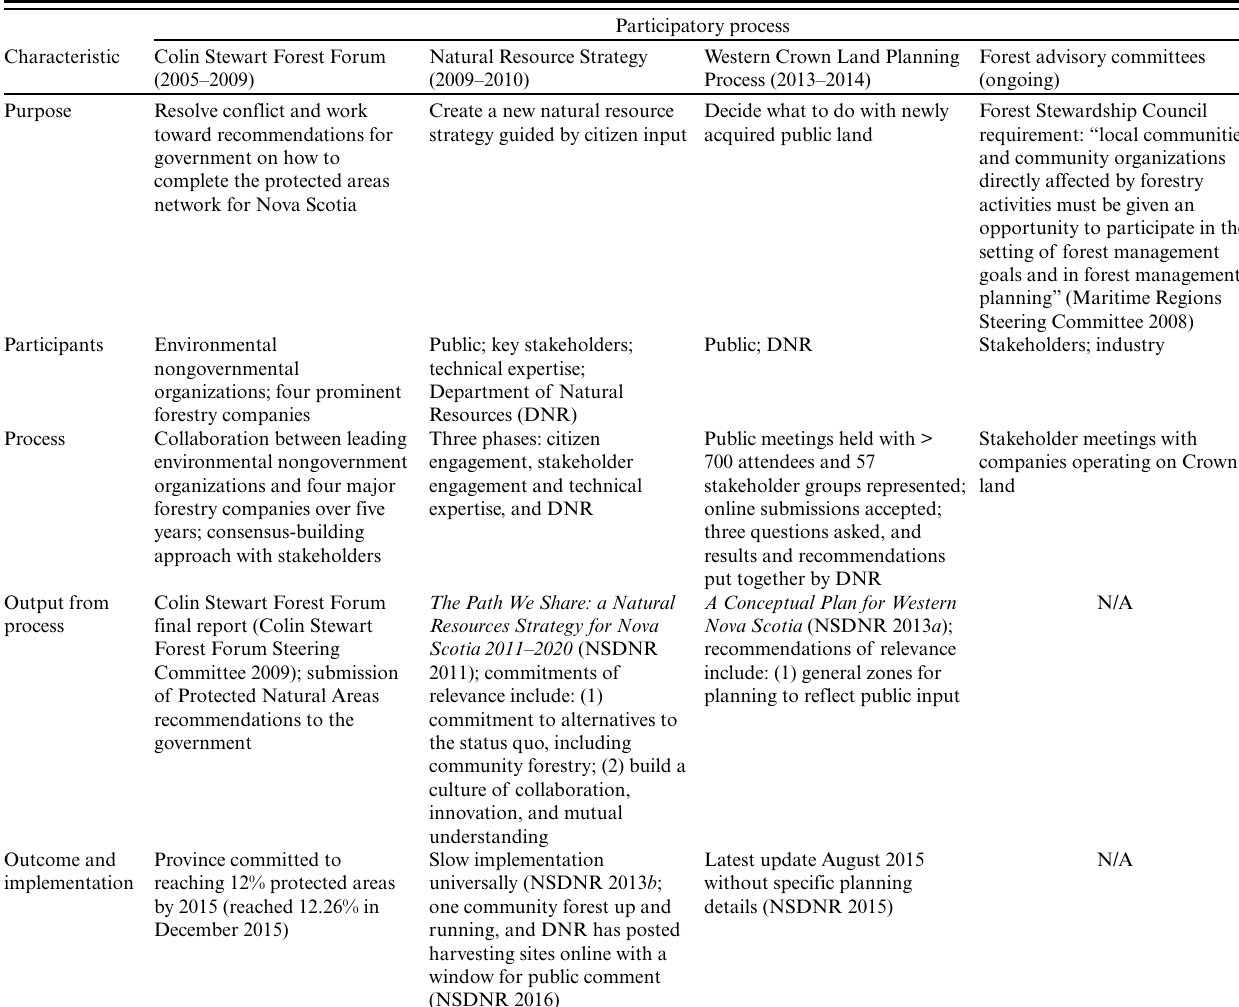
Table 3. Characteristics of the most-discussed participatory processes in Nova